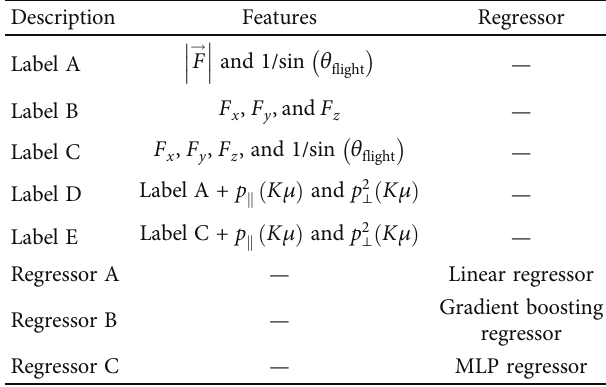
Table 1: Sets of features and regressors used in this